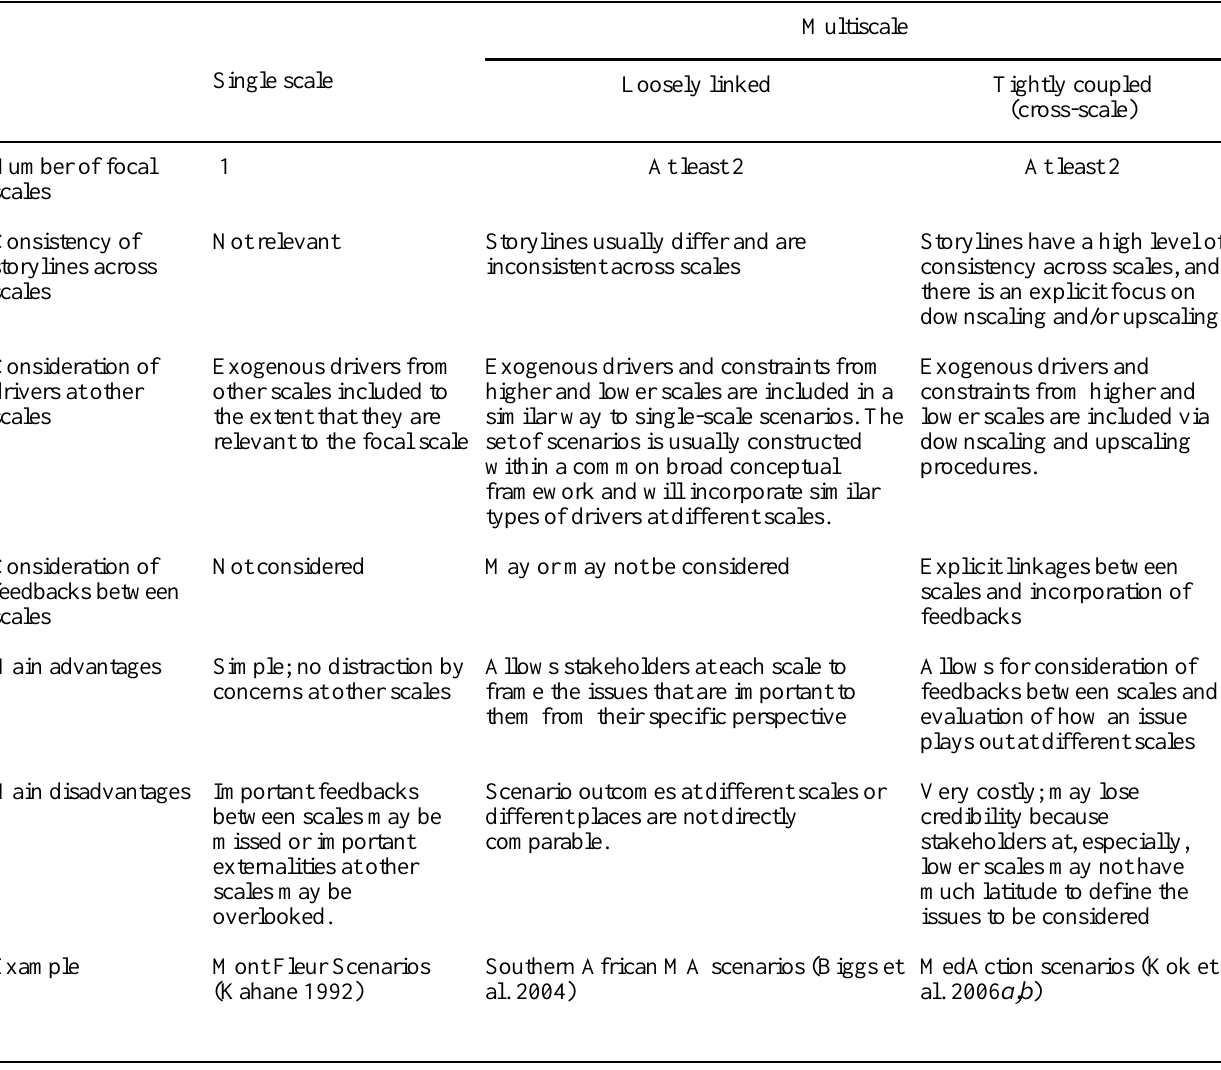
Table 2 . We define three categories of scenarios: single-scale, loosely linked multiscale, and tightly coupled cross-scale. Each of these has specific advantages and disadvantages, and the type most suited to a particular scenario exercise will depend on the objectives of the